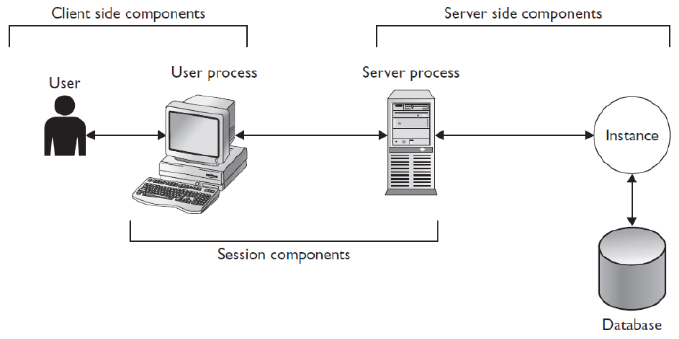
Figure 1. Client-server architecture [1].